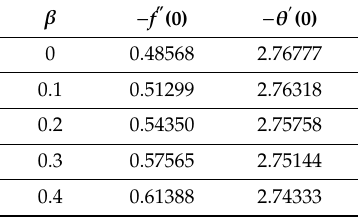
Table 3. The variation of the component of C f and Nu with β ( φ = 0.02, m = 0.05).